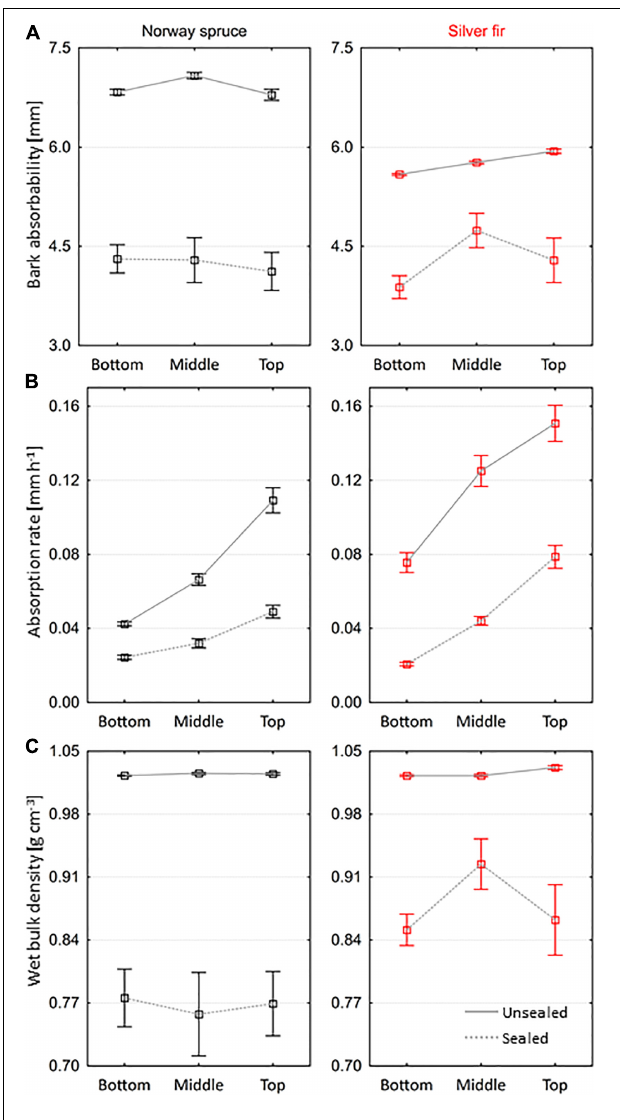
FIGURE 3 | Variation in (A) bark absorbability, (B) rate of water absorption, and (C) wet bulk density of saturated non-silicon and silicone bark samples along stems of Norway spruce and silver fir trees (mean ±